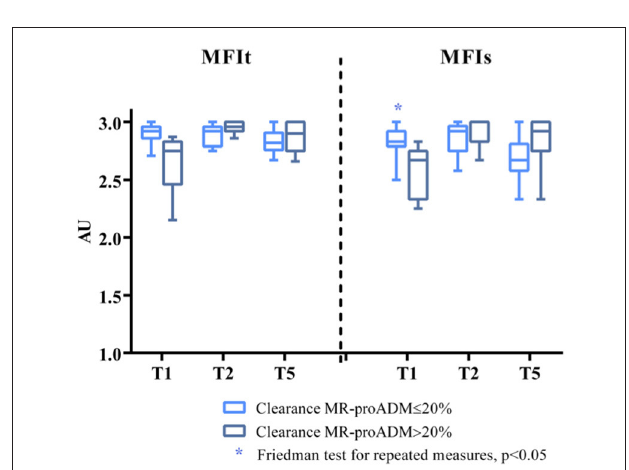
FIGURE 2 | MFIs and MFIt at T1, T2, and T5 in the two groups of patients (clearance of MR-proADM inferior-to-equal or higher than 20%). The Friedman test for repeated measures statistically significant for MFIs in the group of patients with clearance of MR-proADM ≤ 20%. * p <